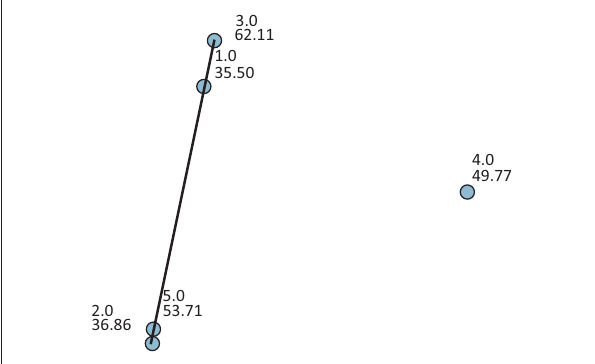
FIGURE 2 : Digitalisation level on hairdressing industry mean rank scores comparison between categories in the industry value chain ( n = 100).